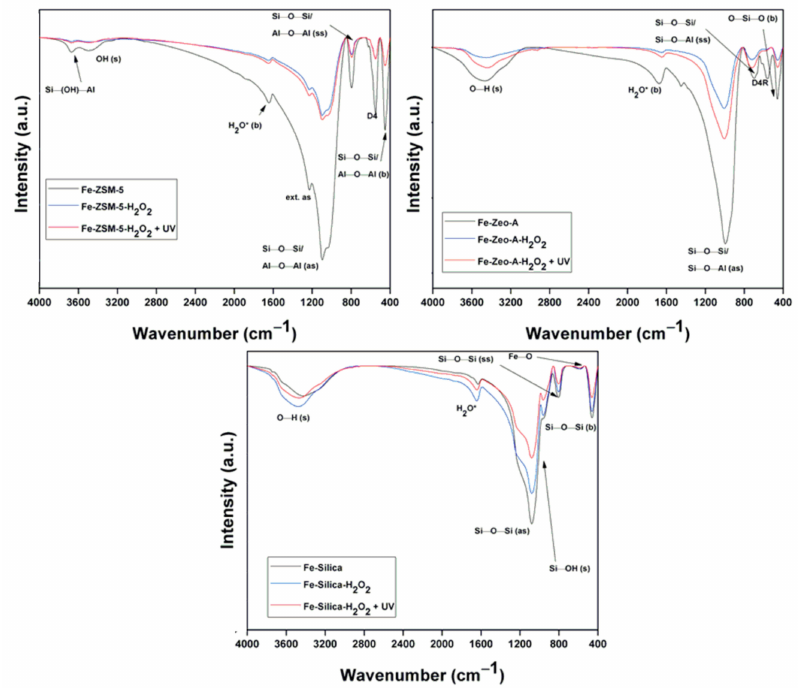
Figure 11. FTIR spectra of Fe-ZSM-5, Fe-Zeo-A, and Fe-Silica after phenol degradation with H 2 O 2 and H 2 O 2 +